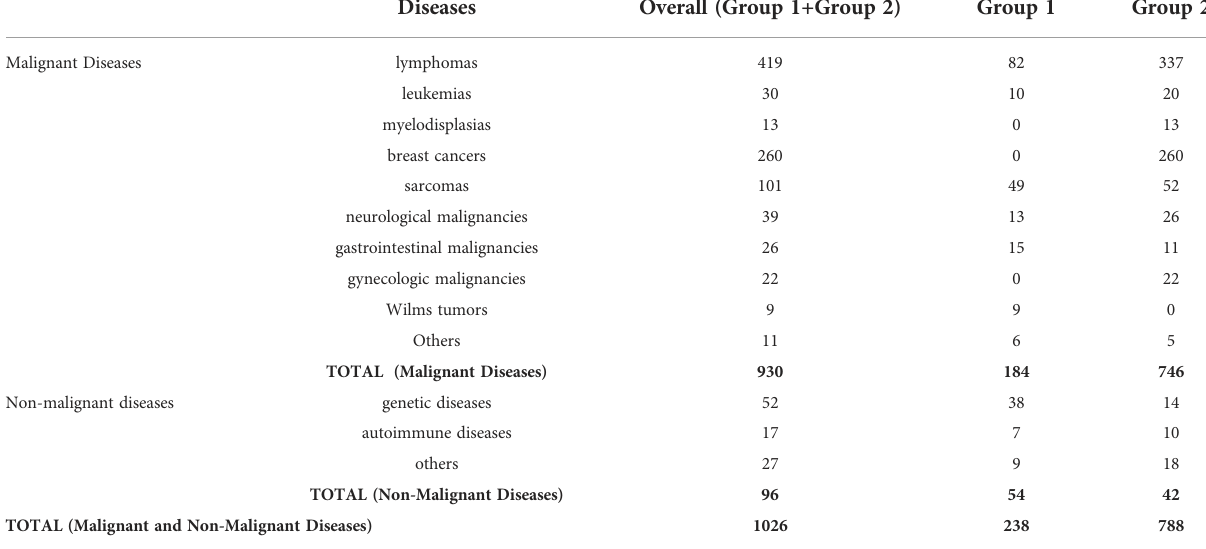
TABLE 1 Type of diagnosis in Group 1 and